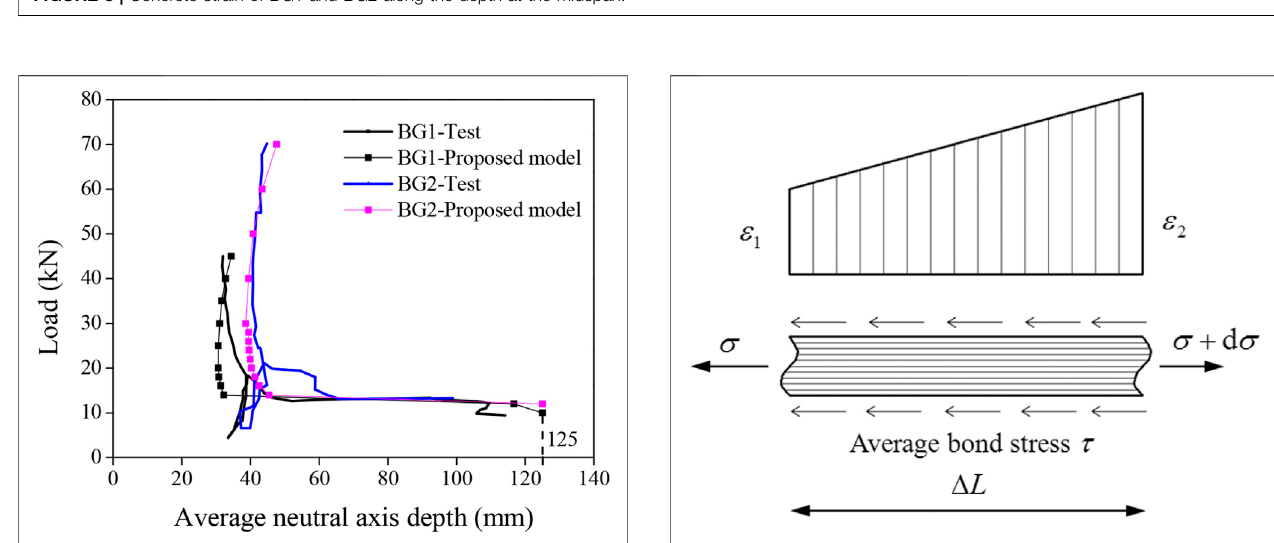
FIGURE 8 | Concrete strain of BG1 and BG2 along the depth at the midspan.